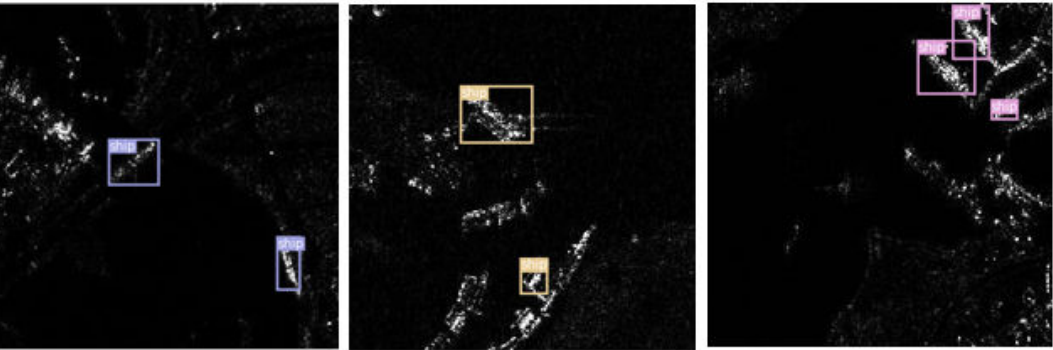
Figure 8. Detection results of improved YOLOv3. Different color means different types of the ships.